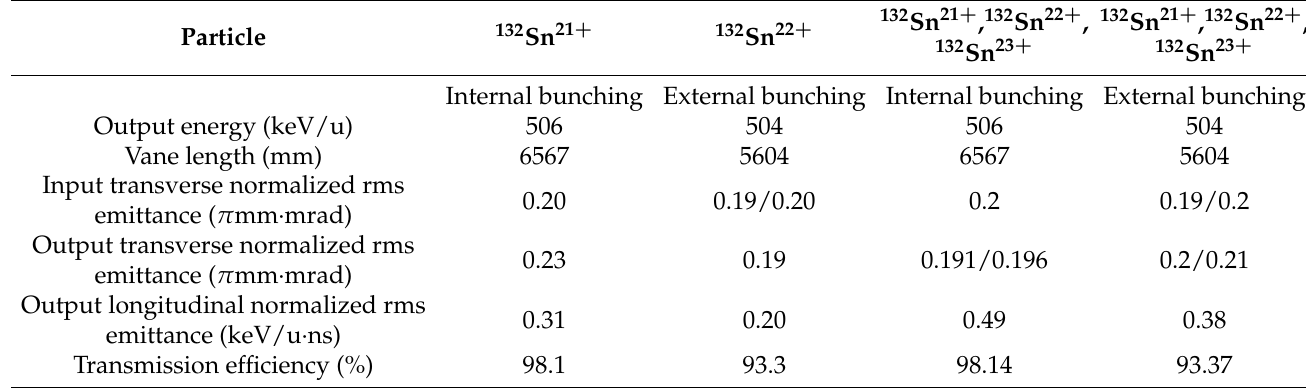
Figure 10. Input distribution of two schemes: (( a ) the internal bunching scheme, ( b ) the external bunching scheme [24]). Table 4. Main parameters of two design